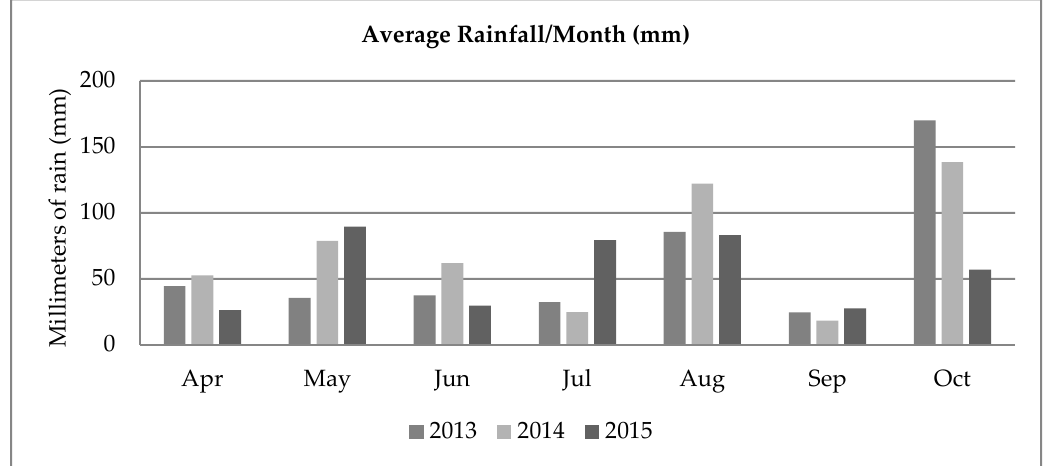
Figure 2. Average rainfall in the three trial years from April to October.